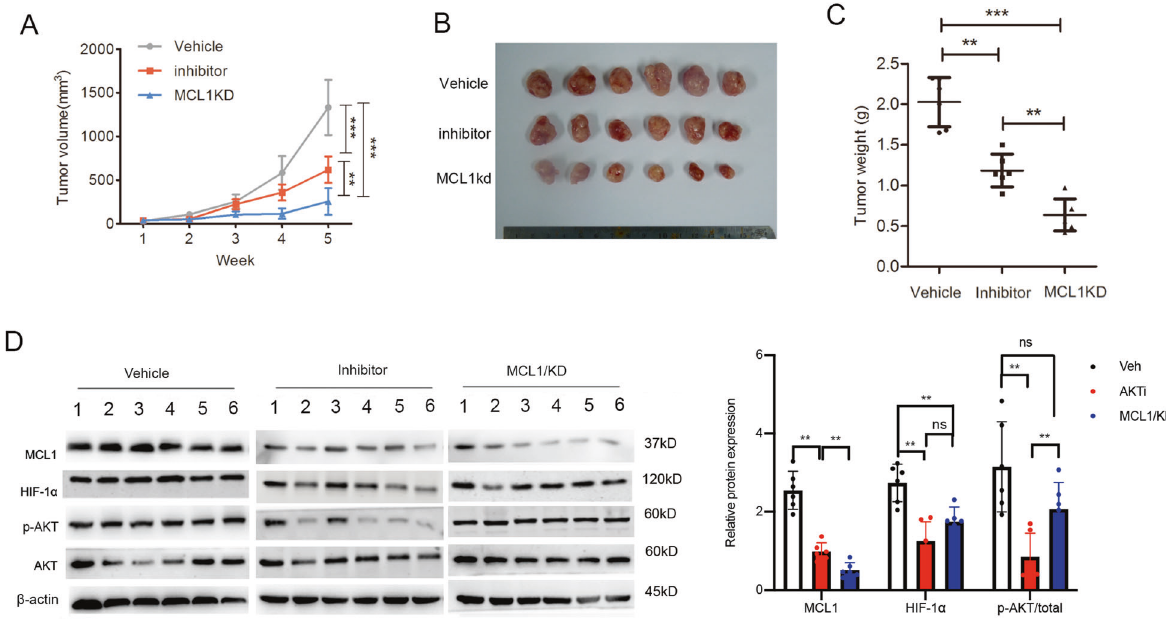
Fig. 6 Inhibition of AKT-MCL-1 signaling increased antitumor effect of radiation therapy in vivo. S26-R cells transfected with MCL-1 shRNA (MCL1/kd) or negative control shRNA were injected subcutaneously into BALB/c nude mice. Then, S26-R cells transfected with the control scrambled shRNA were treated with AKT inhibitor (MK2206, AKTi) or vehicle (veh, used as control) during treatment with radiation. A Tumor volume growth curves; data are shown as the mean ± SD. (** p < 0.01, *** p < 0.001, Student ’ s t -test). B Images of tumors from all mice in the indicated groups ( n = 6/group). C Weight of tumors formed in the indicated groups; data are shown as the mean ± SD. (** p < 0.01, *** p < 0.001, Student ’ s t -test). D Tumor lysates were subjected to immunoblotting, β -actin was used as the loading control (left panel). Levels of the indicated proteins were quanti fi ed and normalized to the signal of β -actin, and phospho-AKT were normalized total AKT and β -actin (right